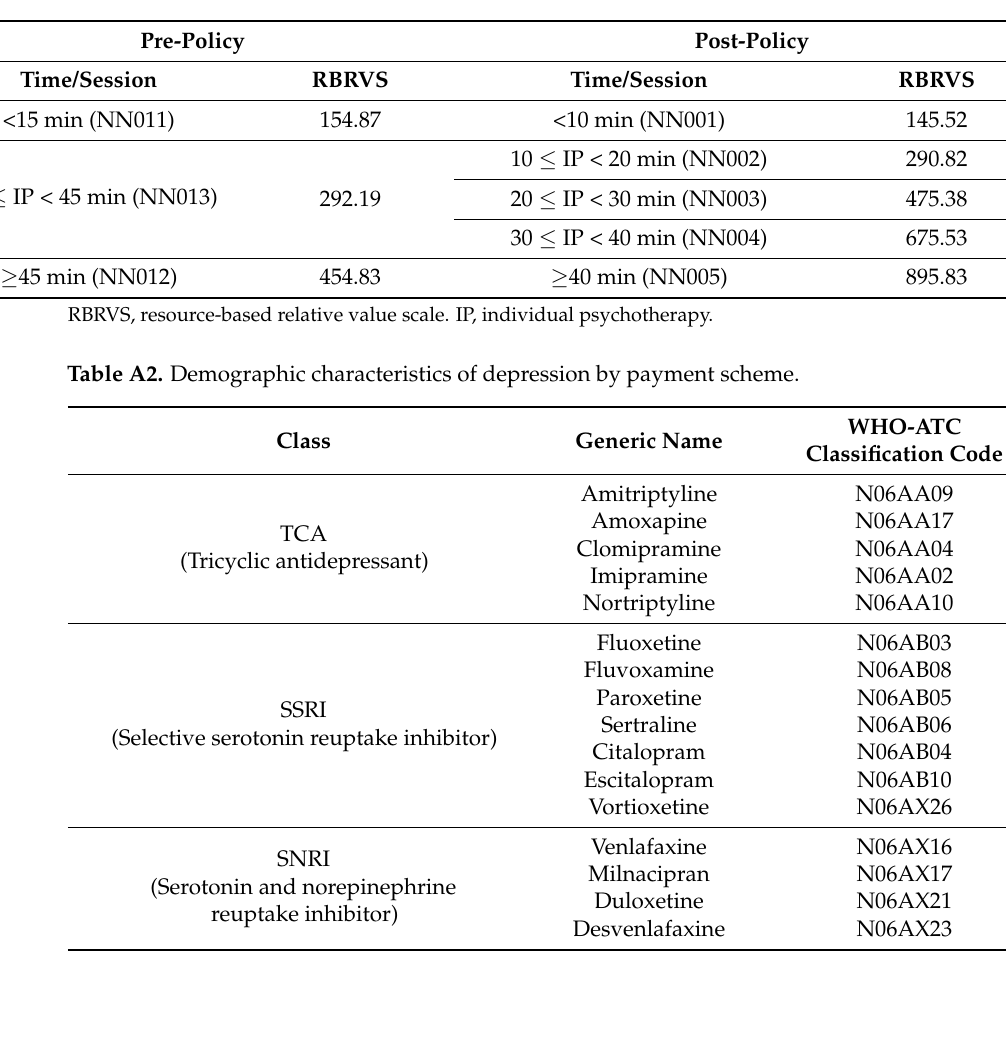
Table A1. Revision of the resource-based relative value scale for individual psychotherapy fees.